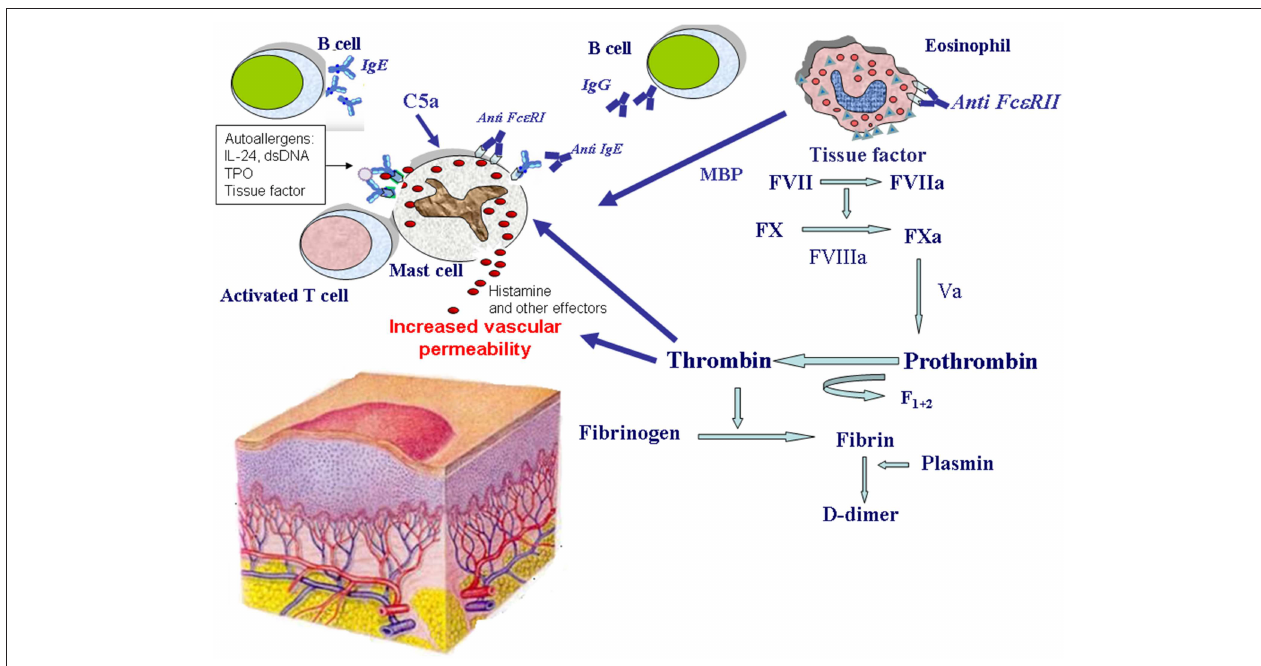
FIGURE 1 | Mechanisms of eosinophil and mast cell activation in chronic spontaneous urticaria. Mast cells release histamine and other effector molecules after stimulation by autoantibodies directed against the high-affinity IgE receptor (Fc ε RI) and IgE, complement anaphylatoxin C5a, eosinophil-derived major basic protein (MBP), thrombin, and IgE-autoallergen complexes. The most important autoallergens are: interleukin-24 (IL-24), double stranded DNA (dsDNA), thyroperoxidase (TPO), tissue factor. Eosinophils are activated by autoantibodies directed against the low-affinity IgE receptor (Fc ε RII) and potentially by other factors. Upon their activation, eosinophils release MBP, and express tissue factor which in turn activates the coagulation cascade (factors VII, X, VIII, V, and prothrombin) leading to thrombin generation. Thrombin induces mast cell degranulation as well as increased vascular permeability. Thrombin generation is demonstrated by the presence of fragment F1 + 2 released from prothrombin after its activation. Finally, fibrin degradation is documented by elevated plasma levels of the fibrin fragment D-dimer during the active phase of the